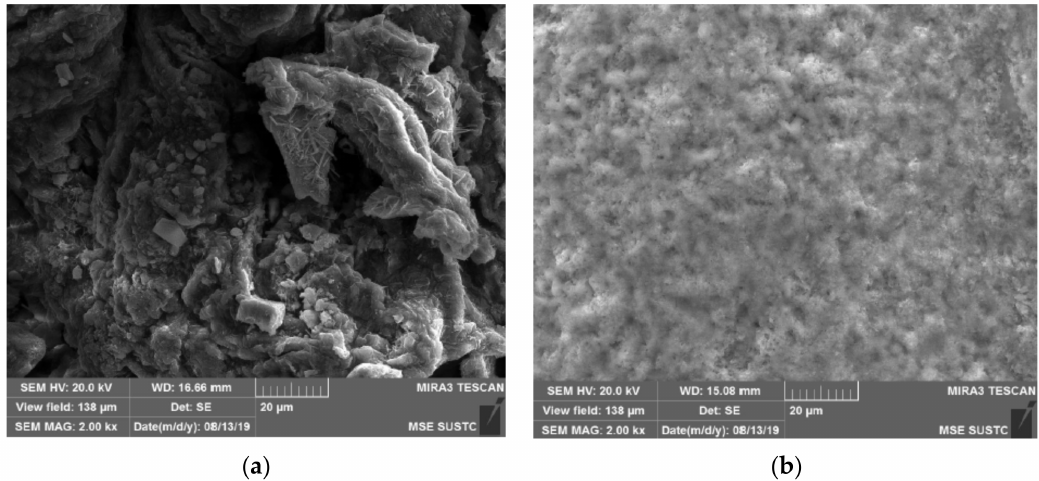
Figure 4. Microscopic morphology of the polymer without ( a ) and with sulfide ion ( b ).